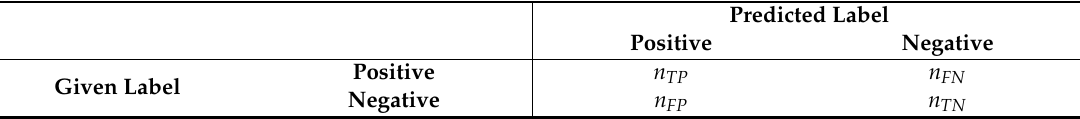
Table 2. The confusion